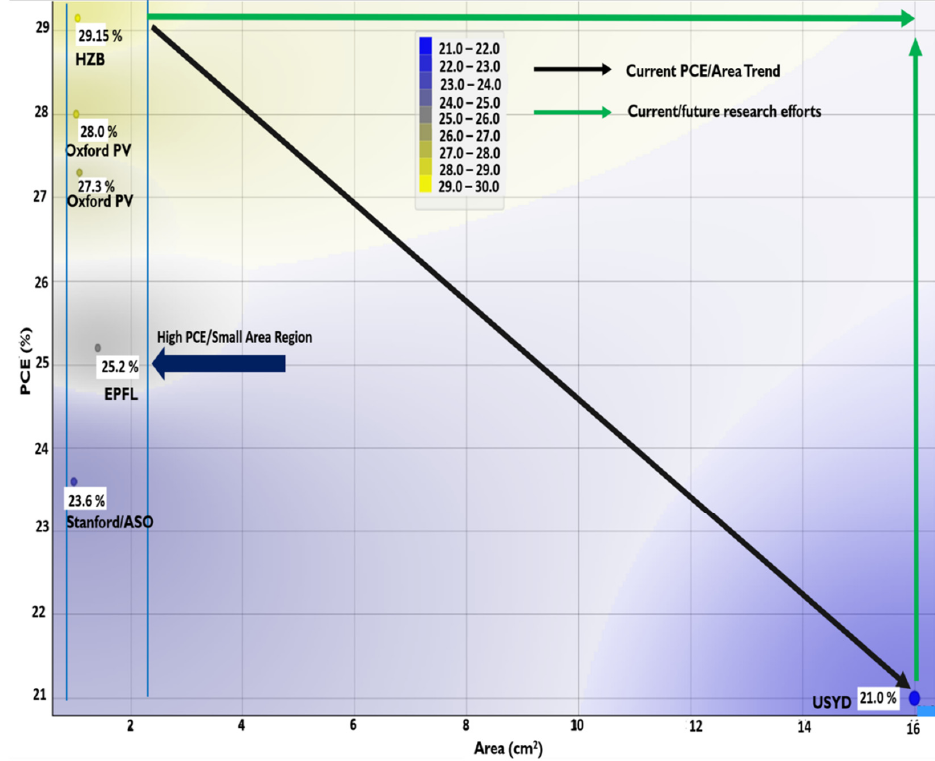
Figure 2. PCE (%) as a function of the area in cm 2 for certified PSC-Si tandem solar cell for various structures since 2016–2020 shown in the navy-blue color zone margins. The lowest right coroner represents uncertified 2018 released by University of Sydney (USYD)-Australia [64]. The figure shows current PCE-Area and research/future trends in the colored arrows. Data has been extracted from solar cell efficiency tables (49–57) available at www.onlinelibrary.wiley.com.